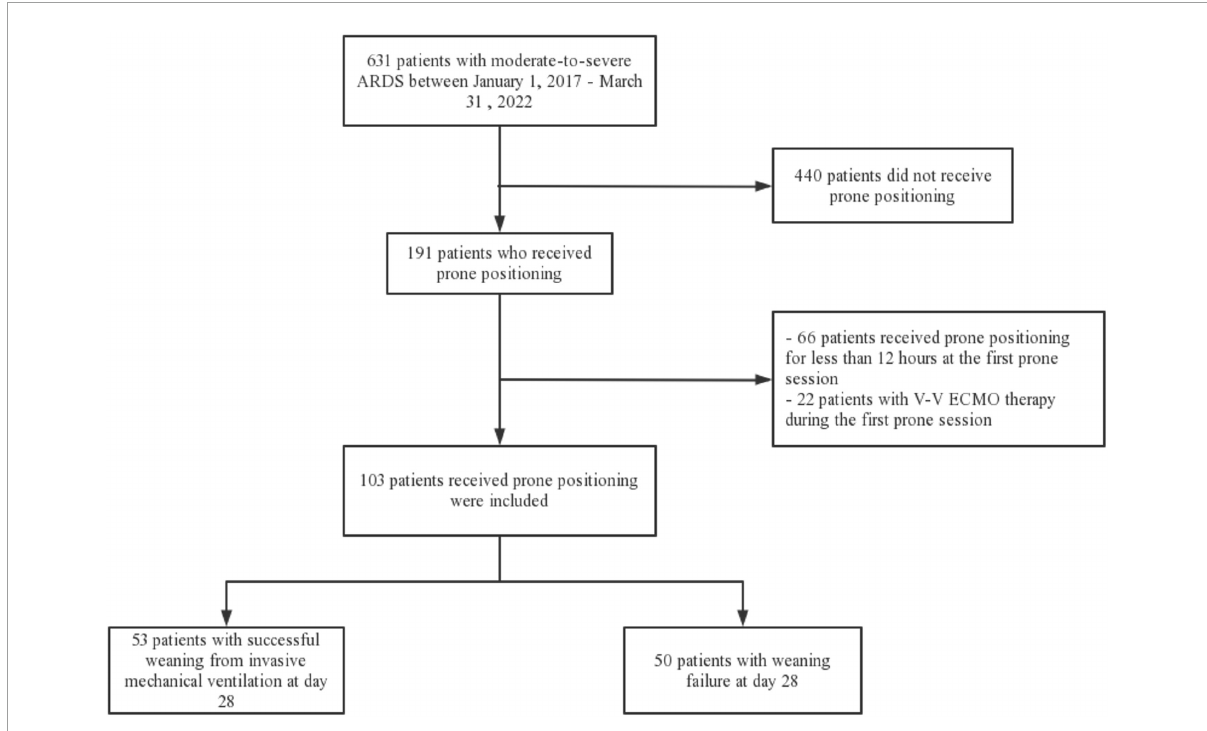
FIGURE1 Flowchart of the study population. ARDS, acute respiratory distress syndrome; V-V ECMO, venovenous extracorporeal membrane